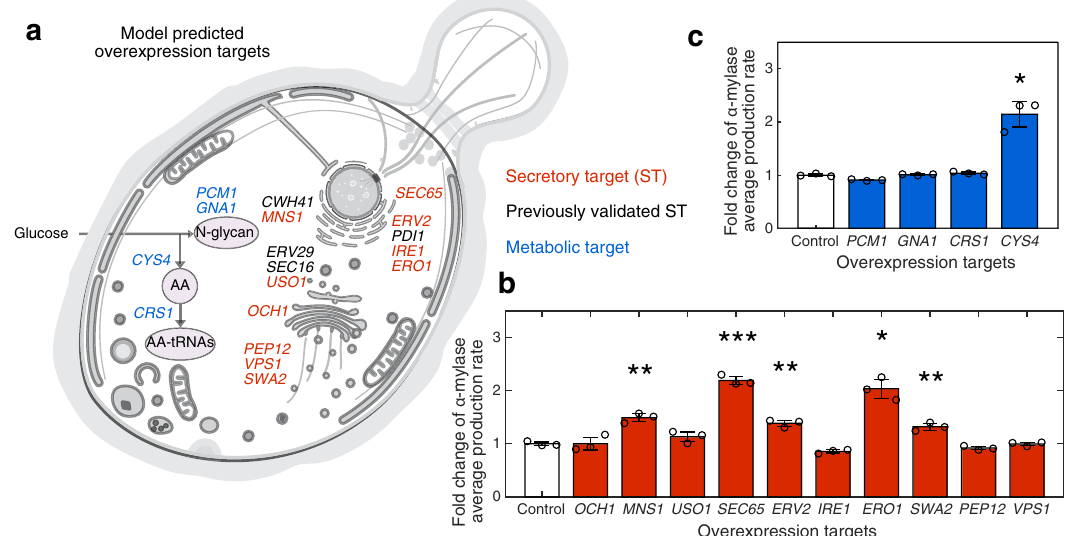
Fig. 6 Validation of selected predicted overexpression targets for α -amylase overproduction. a Protein localization of the selected predicted overexpression targets. Yeast compartmentalized fi gure is from SwissBioPics under CC BY 4.0 license. b Validation result of predicted secretory targets. c) Validation result of predicted metabolic targets. Statistical analysis was performed using a Student ’ s t -test (two sample, two tailed, unequal variance, *: P < 0.05, **: P < 0.01, ***: P < 0.001). The gene fragments were ampli fi ed from the yeast genome and assembled into the pSP-GM1 expression vector under the control of TEF1 promoter, respectively. Data are shown as average values ± standard errors of independent biological triplicates. α -amylase was under stable expression on the multicopy plasmid CPOTud under the control of TPI1 promoter in a tpi deletion background strain. GNA1 (Glucosamine-6- phosphate acetyltransferase); PCM1 (Phosphoacetylglucosamine mutase); CRS1 (Cysteinyl-tRNA synthetase); CYS4 (Cystathionine beta-synthase); CWH41 (Processing alpha glucosidase I); OCH1 (Mannosyltransferase of the cis-Golgi apparatus); MNS1 (Alpha-1,2-mannosidase); USO1(Intracellular protein transport protein from ER to Golgi); SEC65 (Signal recognition particle subunit); ERV2 (FAD-linked sulfhydryl oxidase); IRE1 (Serine/threonine-protein kinase/endoribonuclease); ERO1 (Endoplasmic oxidoreductin-1); SWA2 (Auxilin-like clathrin uncoating factor); VPS1 (Vacuolar protein sorting-associated protein); ERV29 (ER-derived vesicles protein); PEP12 (Syntaxin); PDI1 (Protein disul fi de-isomerase); SEC16 (COPII coat assembly protein). P values: P PCM1 : 0.0119, P GNA1 : 0.6231, P CRS1 : 0.1728, P CYS4 : 0.0199, P OCH1 : 0.9804; P MNS1 : 0.0048; P USO1 : 0.1723; P SEC65 : 0.0004; P ERV2 : 0.003; P IRE1 : 0.0119; P ERO1 : 0.0115; P SWA2 : 0.0078; P PEP12 : 0.0469; P VPS1 : 0.9431. Source data are provided as a Source Data fi